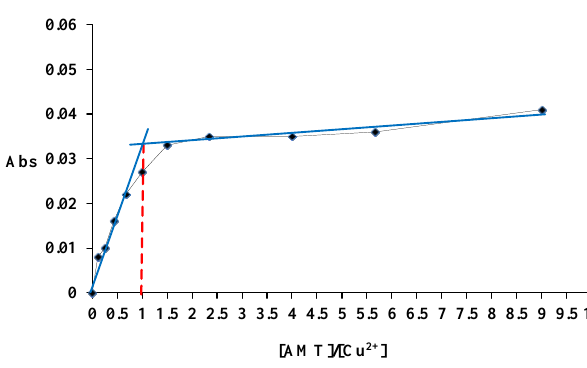
Figure 2. Determination of the stoichiometry of the Cu(II)–AMT complex. Blue lines represent the tangents of the linear portions of the mole ratio curve, while red dashed line shows the molar ratio.